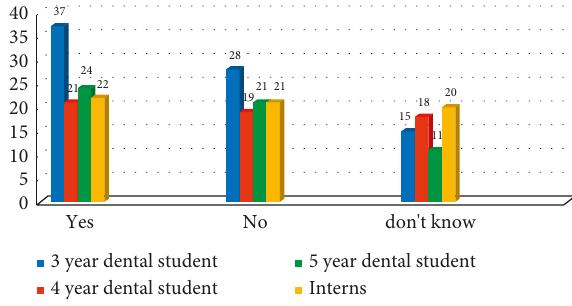
Figure 1: Education and knowledge of participants on radiation 49.64 with P 0 . protection ( χ 2 (cid:31) ≤